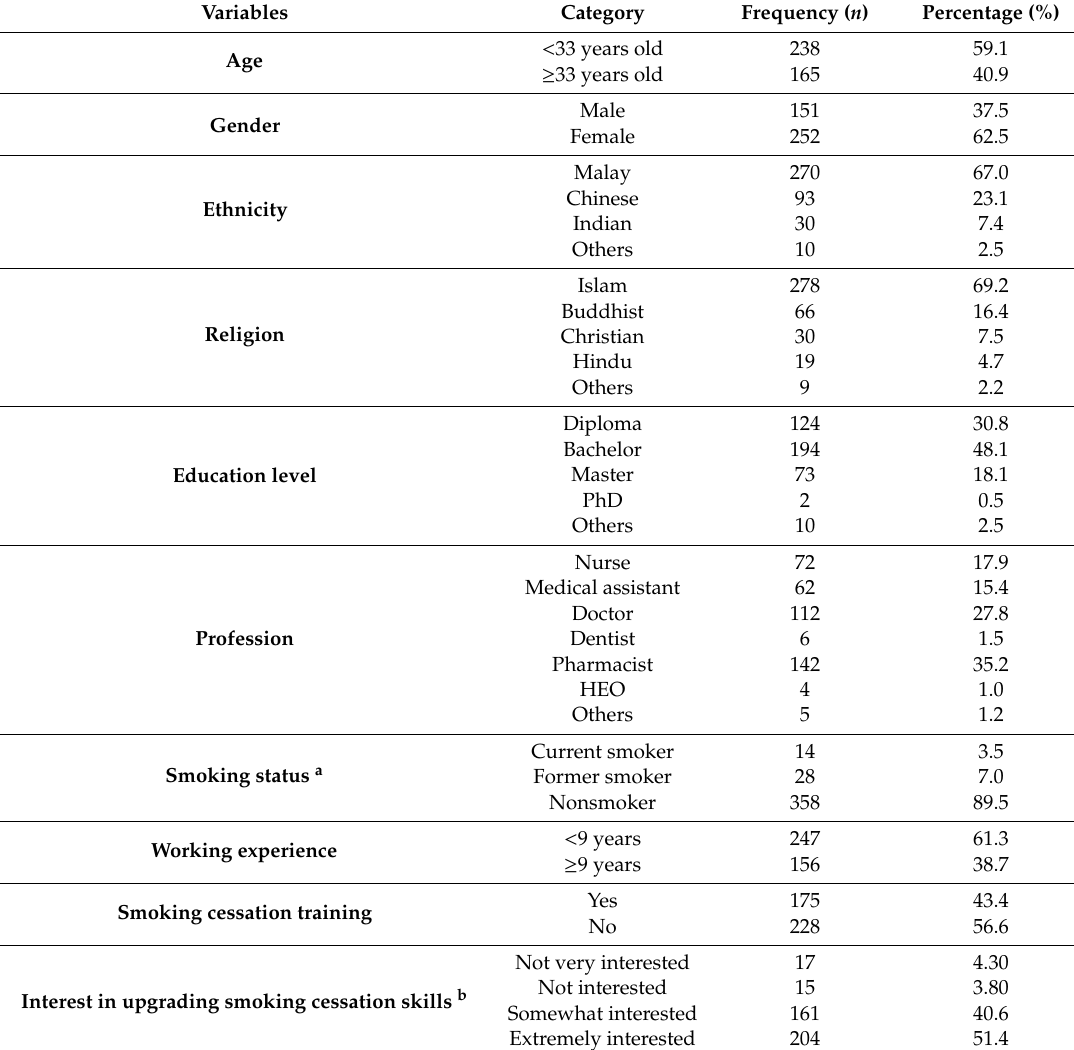
Table 4. Healthcare providers’ characteristics ( n =